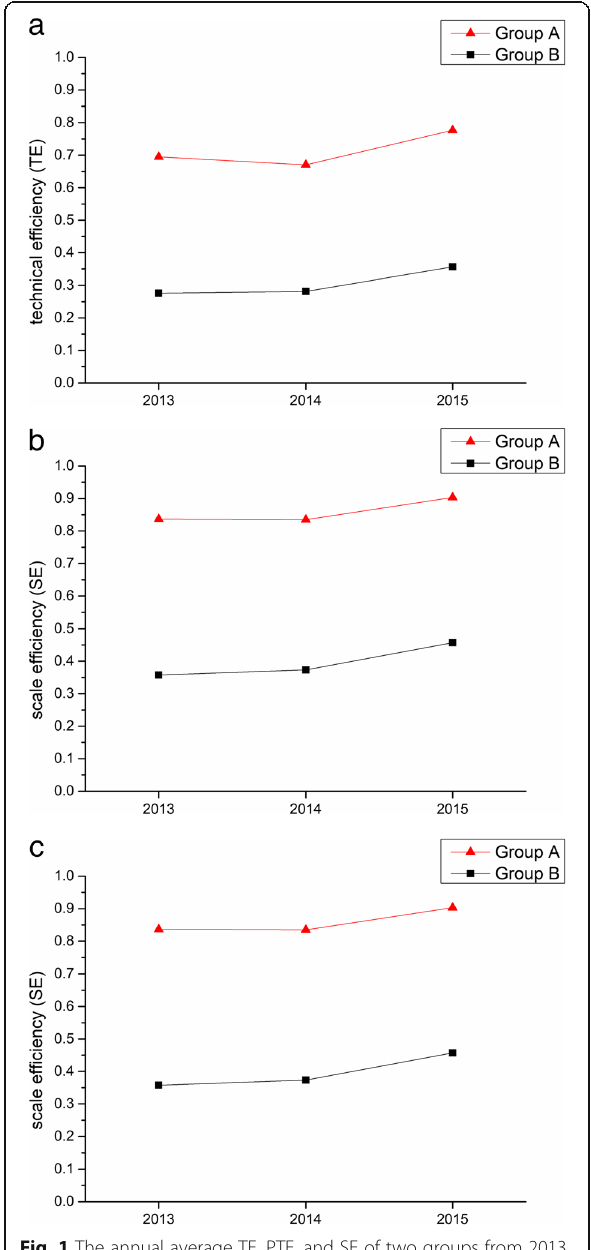
Fig. 1 The annual average TE, PTE, and SE of two groups from 2013 to 2015. a The annual average TE of the two groups from 2013 to 2015. Red line with up-triangle indicates the annual average TE of group A from 2013 to 2015. Black line with square indicates the annual average TE of group B from 2013 to 2015. b The annual average PTE of the two groups from 2013 to 2015. Red line with up- triangle indicates the annual average PTE of group A from 2013 to 2015. Black line with square indicates the annual average PTE of group B from 2013 to 2015. c The annual average SE of the two groups from 2013 to 2015. Red line with up-triangle indicates the annual average SE of group A from 2013 to 2015. Black line with square indicates the annual average SE of group B from 2013 to